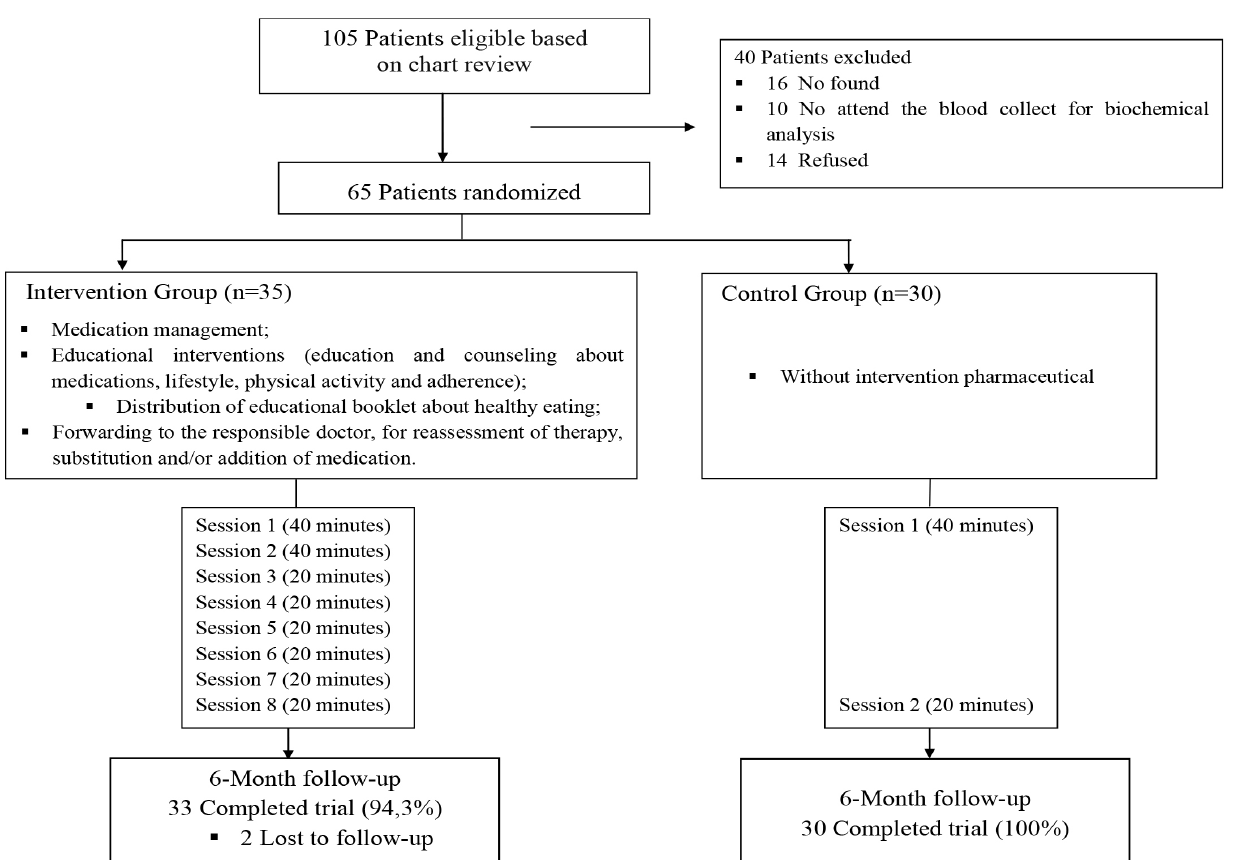
FIGURE 1 - Flowchart of the formation of the study